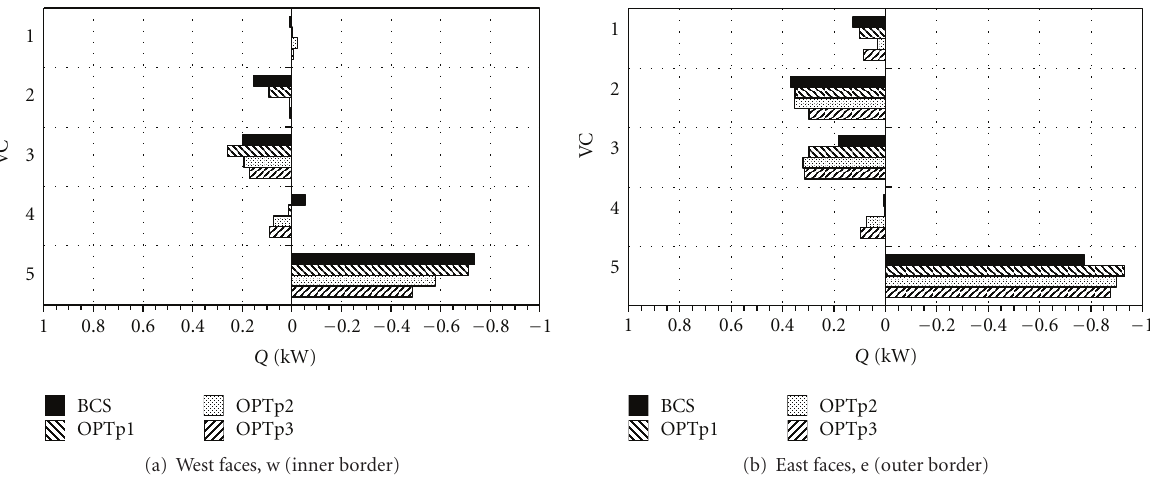
Figure 4: Enthalpic flow rate predictions across West (inner border) and East (outer border) of the air curtain control volumes, per unit length—OPTp cases study.